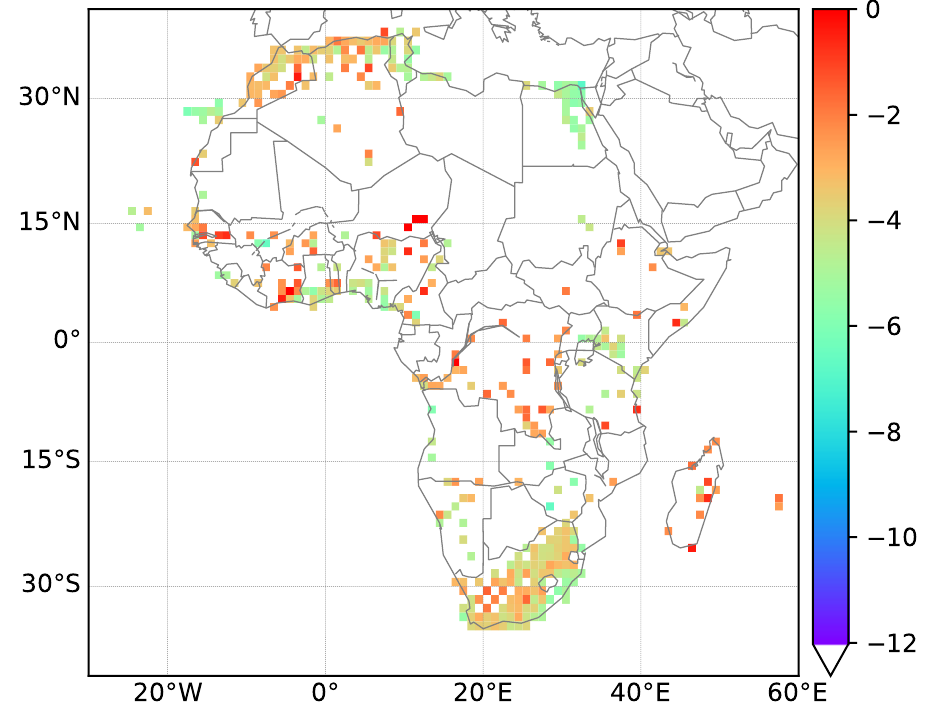
Figure 13. Heatmap of Africa showing the density of streets mapped to French street specifics. Colors indicate the density of streets in this area, thus the logarithmic value of the number of streets normalized by all streets in the cell of the